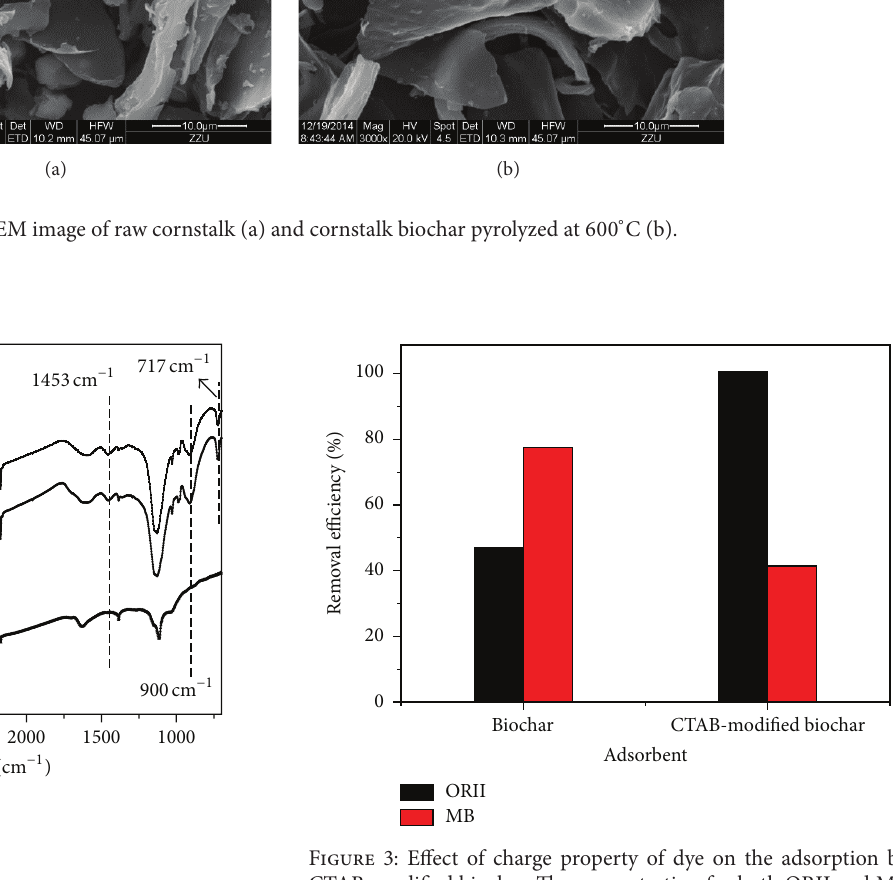
Figure2:FTIRspectraofrawbiochar,CTAB-modifiedbiochar,and exhausted CTAB-modified biochar.